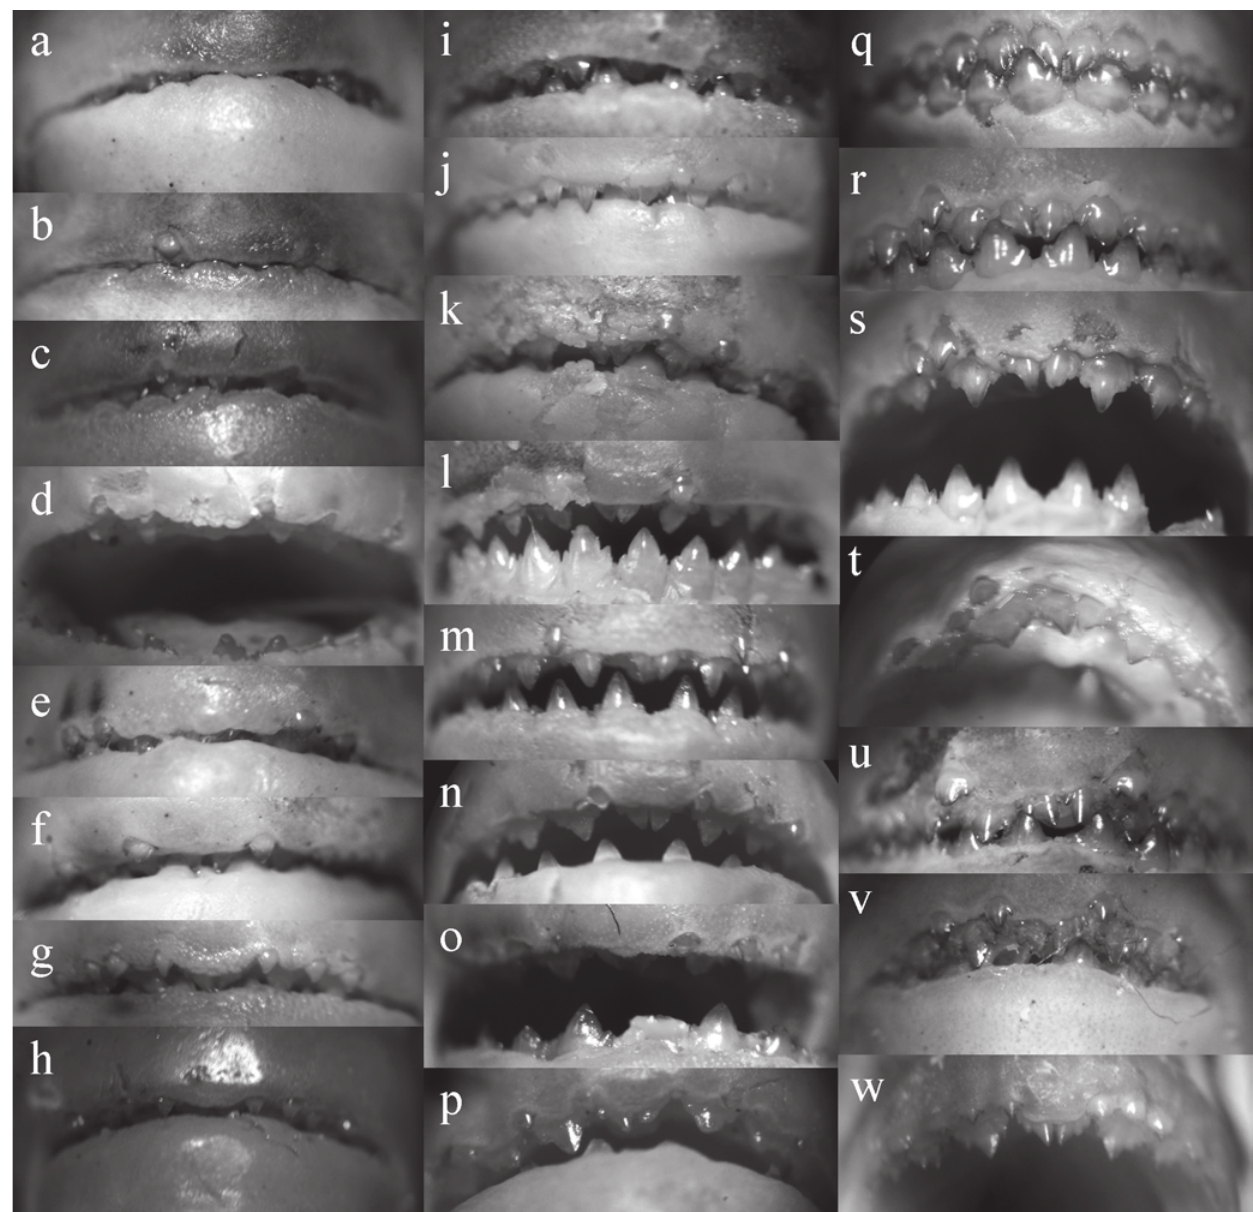
Fig. 5. Some examples of dental and lip polymorphisms displayed by Astyanax gymnodontus , with the number of the lot (all of NUP collection), SL in mm, and the number of premaxillary teeth in the outer row, on the left and right sides (in parentheses). Left column, well-developed lips: (a) 1583, 65.2 (0-0), (b) 4062, 97.1 (1-0), (c) 1653, 64.2 (1-1), (d) 618, 128.5 (1-3), (e) 3766, 97.5, (2-1), (f) 1643, 105.4 (2-3), (g) 3686, 92.2 (4-3), (h) 2719, 99.9 (4-4); middle column, ill-developed lips: (i) 2297, 53.8 (0-1), (j) 1582, 93.2 (0-2), (k) 1582, 85,2 (0-3), (l) 4348, 80.1 (1-1), (m) 2050, 66.2 (1-2), (n) 1579, 72.0 (1-3), (o) 1643, 99.0 (3-3), (p) 635, 65.4 (3-4); right column, lacking lips: (q) 1583, 99.9 (0-0), (r) 3766, 100.2 (1-0), (s) 1583, 98.0 (2-0), (t) 1579, 75.1 (3-0), (u) 3707, 68.0 (1-1), (v) 3037, 97.4 (2-2), (w) 1583, 80.4